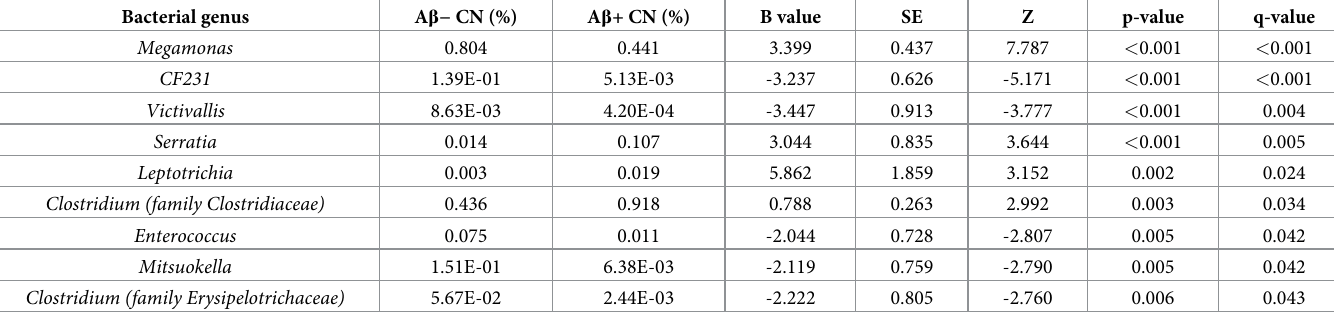
Table 2. GLM analysis results of taxonomic differences in microbiome between A β + CN participants and A β − CN participants. Bacterial